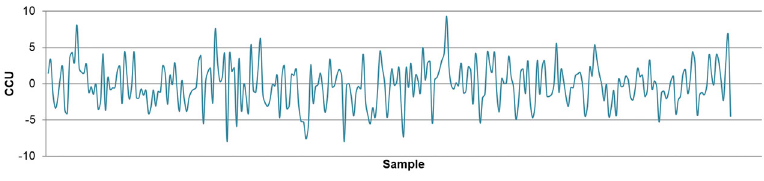
Figure A31. Prediction error of NN1 model validation dataset. Table A3. Regression statistics parameters of NN1 model datasets.